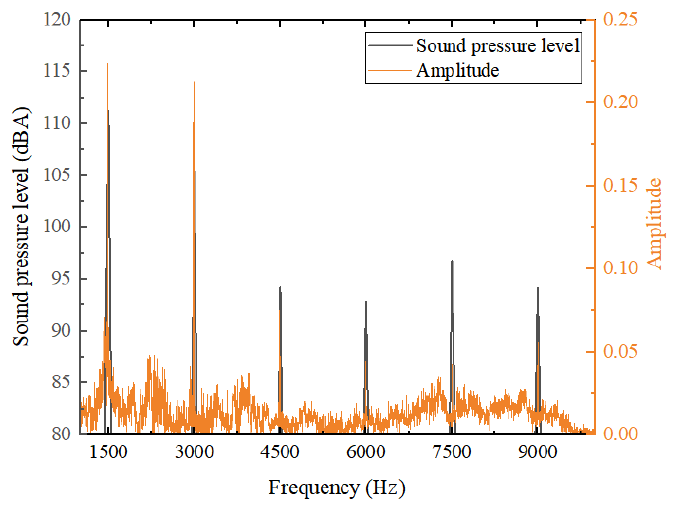
Figure 14. Validation of the CFD – BEM coupling model.